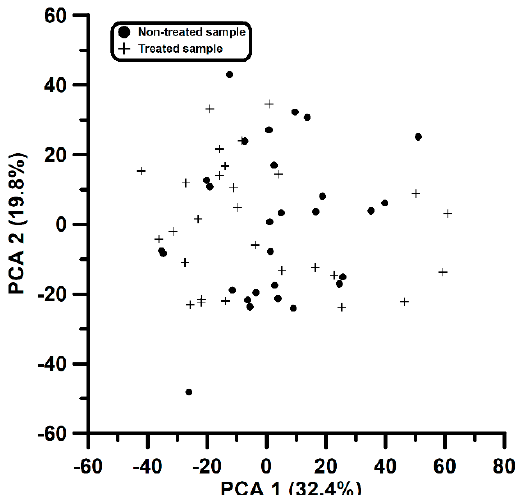
Figure 1. Typical results obtained during the first study by means of PCA. No clear separation of samples (non-treated 0 and treated 1) was